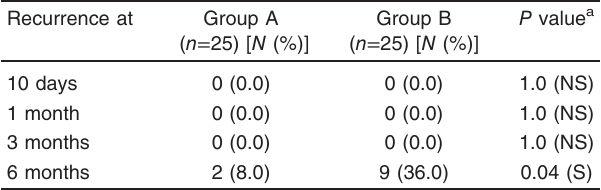
Table 3 Comparison between both groups as regards adenoid recurrence at different time intervals